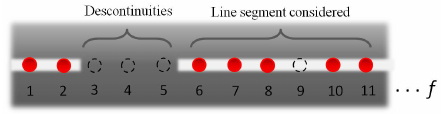
Figure 4: Discontinuities of the classification of seed